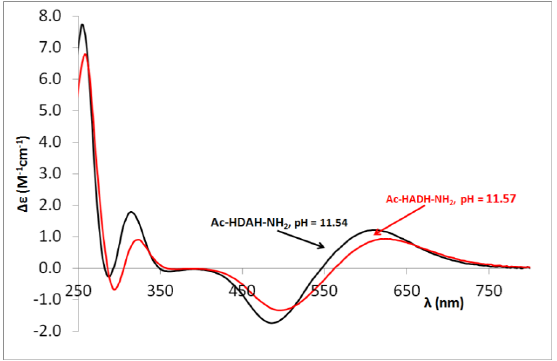
Figure A2. CD spectra registered in equimolar solution of Ac-HADH-NH 2 ( ■ ) and Ac-HDAH-NH 2 ( ■ ) systems at pH 11.5. Molecules 2022 , 27 , x FOR PEER REVIEW